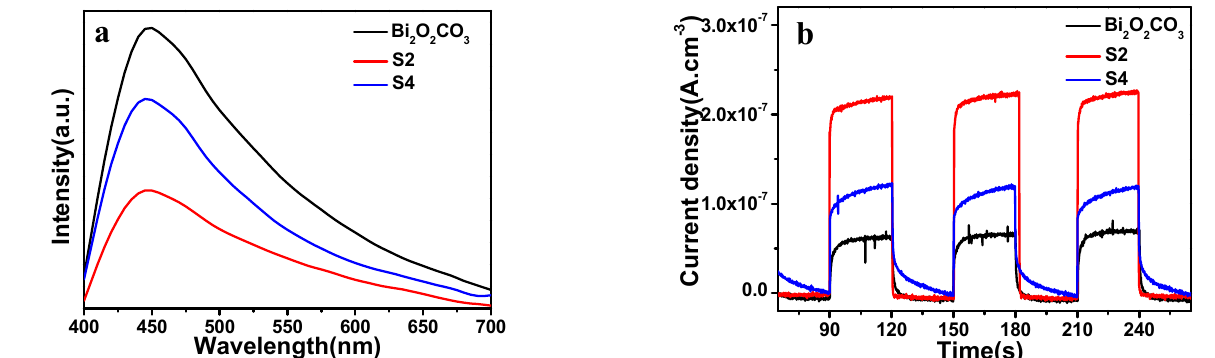
Figure 8. The room temperature PL spectra ( λ ex = 320 nm) ( a ) and photocurrent spectra ( b ) of B i2 O 2 CO 3 , S2 and S4 samples. In order to obtain the relative positions of the conduction band (CB) and valence band (VB) edges, VB-XPS of Bi 2 O 2 CO 3 and S4 (pure BiOI) were characterized (Figure 9). The E VB top of Bi 2 O 2 CO 3 and S4 locate at 1.78 and 1.15 eV, respectively. On the basis of the VB position and their band gaps, the CB edge potentials of Bi 2 O 2 CO 3 and BiOI are estimated to be − 1.18 and − 0.6 eV, respectively through the equation E CB = E VB .